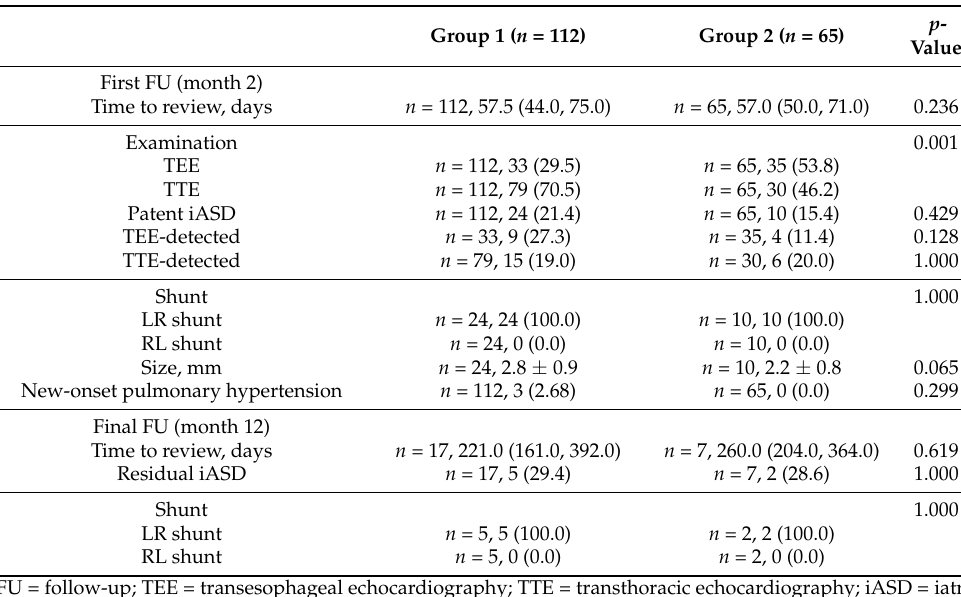
Table 3. Follow-up.